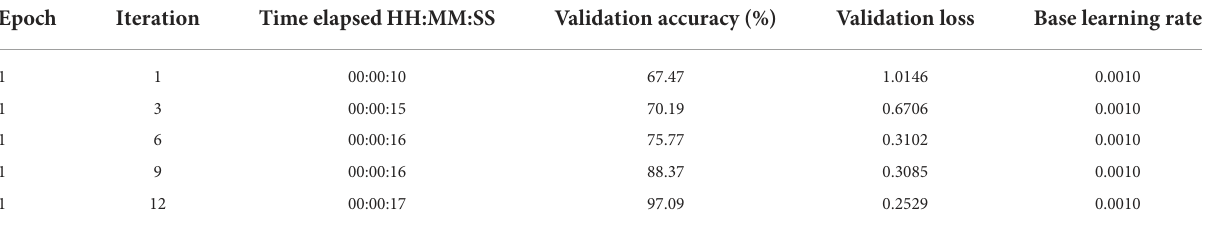
TABLE 2 Training results for the first